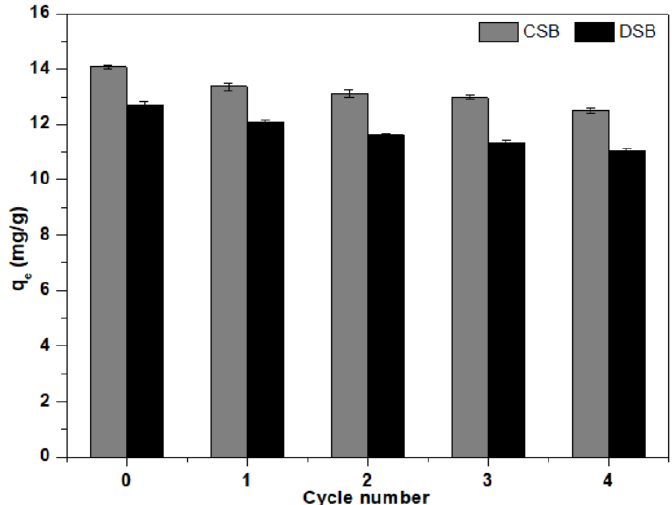
Figure 5. Adsorption capacity of 17 β -estradiol (E2) onto corn straw and dewatered sludge biochars (CSB and DSB) during four adsorption–desorption cycles.